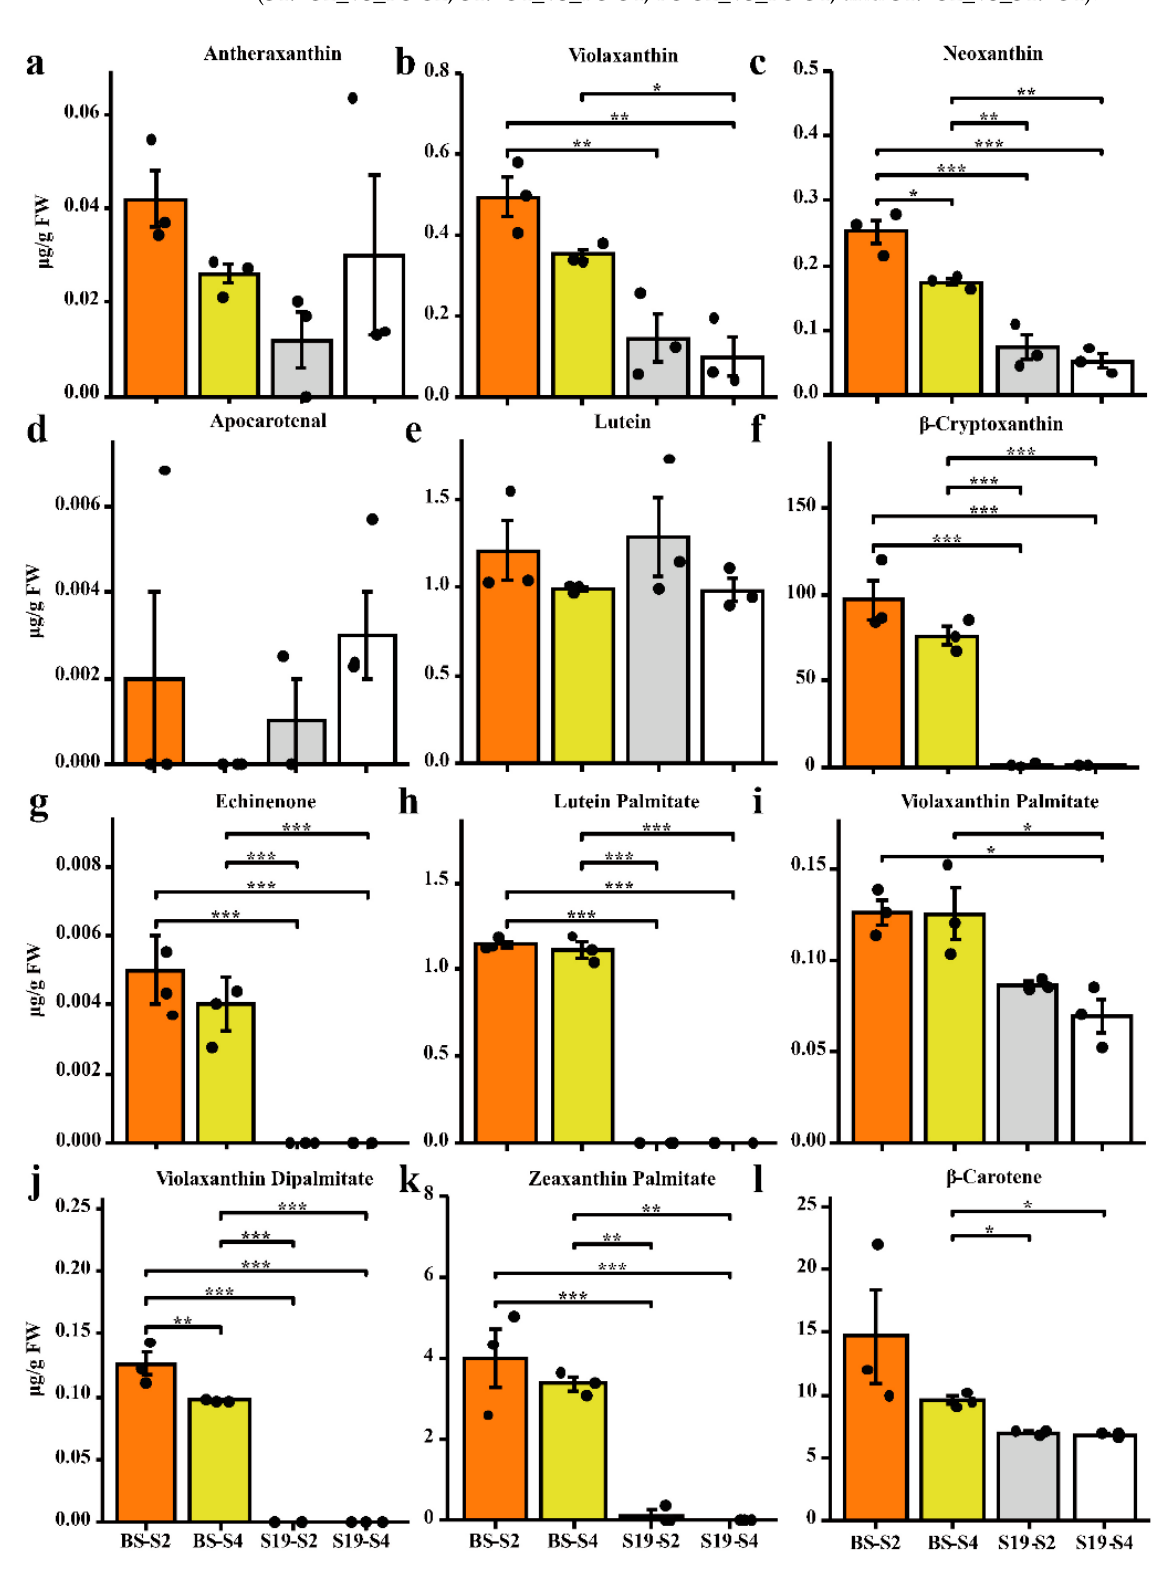
Figure 2. Analysis of carotenoid levels in sweet potato samples. The content of lutein ( a – g ), carotenoid esters ( h – k ), and carotene ( l ). Data are means ± SEM ( n = 3). *** p < 0.001, ** p < 0.01, * p < 0.05.